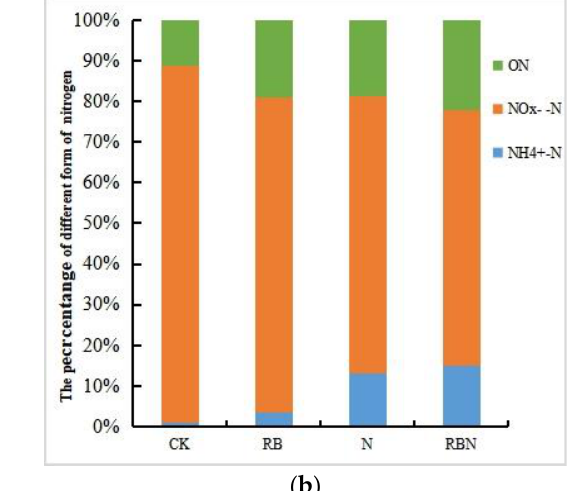
Figure 6. ( a ) Cumulative content of nitrogen; ( b ) the percentage of different forms of nitrogen. Different letters in the image(a) indicate significant differences between treatments (p < 0.05).